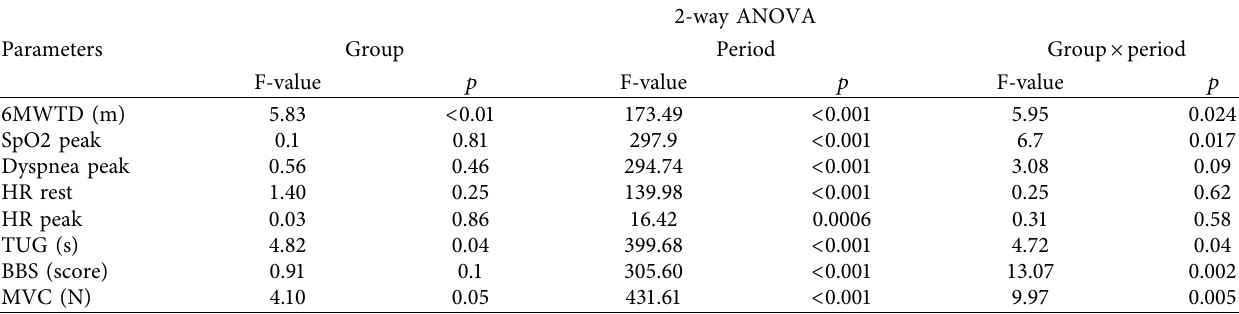
Table 2: Statistical results of the ANOVA analysis of exercise tolerance, dynamic balance, and maximal voluntary contraction parameters (2-way ANOVA).